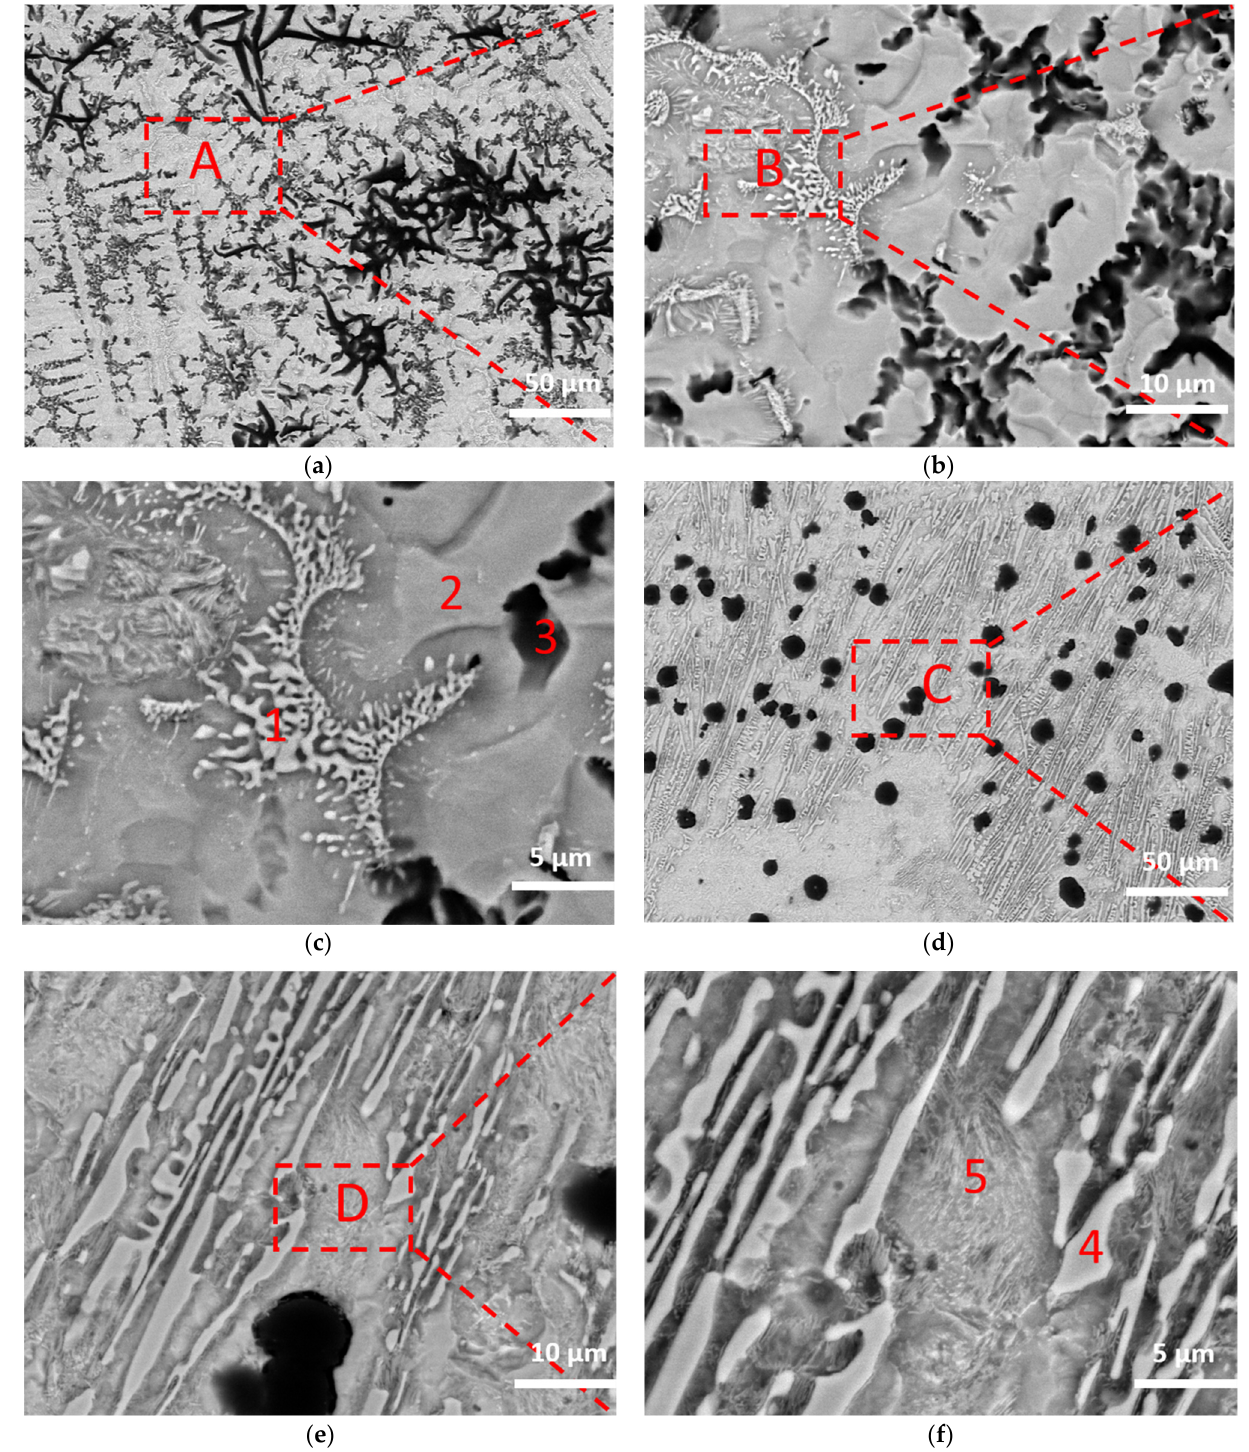
Figure 7. Microstructure of the coatings prepared at 50 A: ( a ) coating zone, ( b ) magnification of position A, ( c ) magnification of position B, ( d ) bonding zone, ( e ) magnification of position C, ( f ) magnification of position D. Table 4. Point analysis of elements in the selected areas.